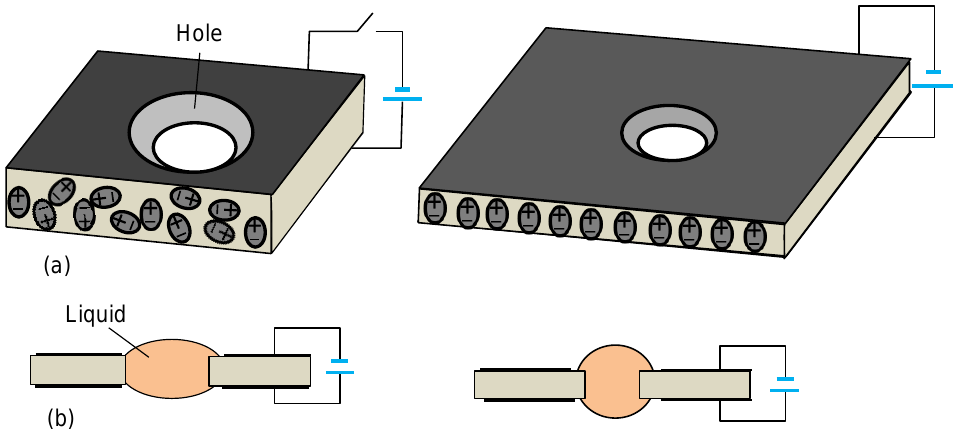
Figure 3. The DEA film with a through hole for actuating a liquid droplet: ( a ) no droplet in the hole. Left is the relaxed state and right is the stressed state, ( b ) with a droplet in the hole. Left: relaxing state and right: stressing state.